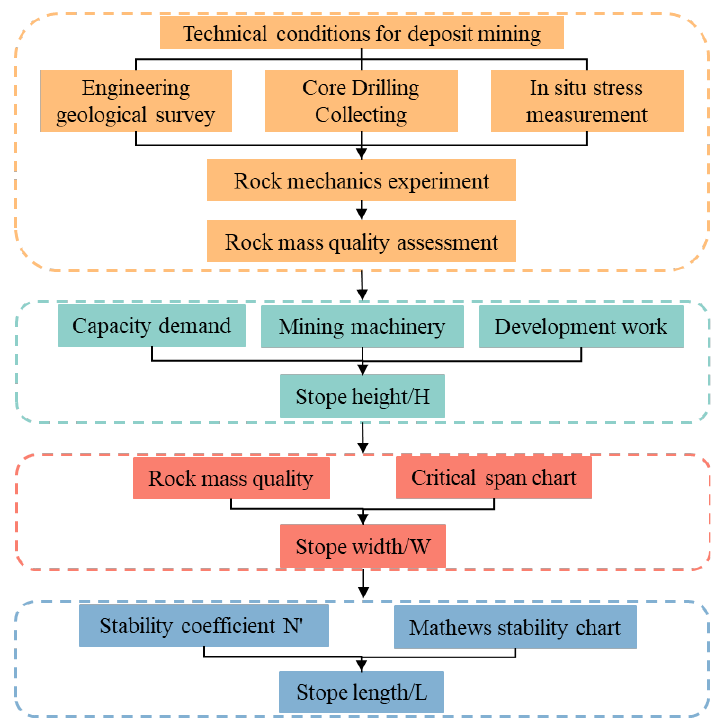
Figure 3. Design process of stope structural parameters.